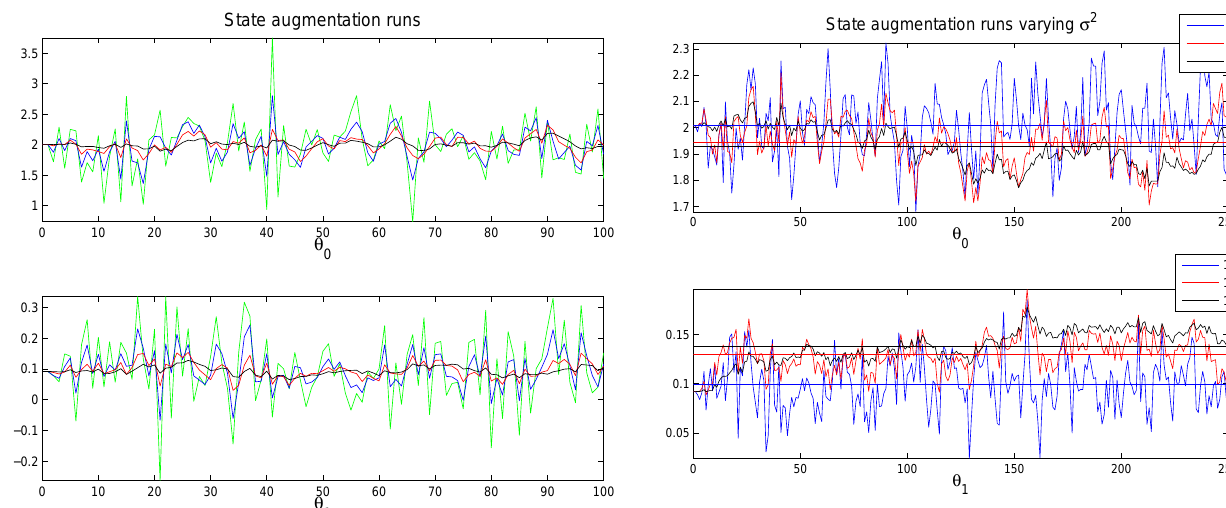
Fig. 11. Runs using the EKF version of the SA method, when the di- agonal elements of C θ are taken to be 0 . 1% (black), 1% (red),10% (blue) and 100 % (green) of the optimal initial values. The effect of the size of C θ was as expected. When C θ is set to be small, the method reacts slowly on new data and the parameter values take small steps.